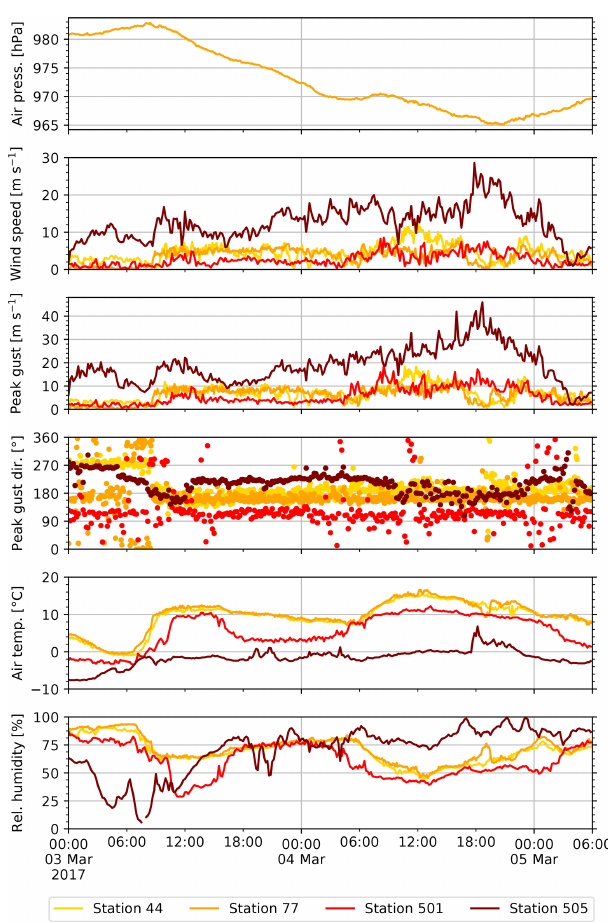
Figure 3. Level 2 time series data of meteorological conditions be- fore and during the passage of midlatitude Cyclone Xaver on 3– 5 March 2017 at four different WegenerNet stations – two in the Feldbach region (44 and 77) and two in the Johnsbachtal region (501 and